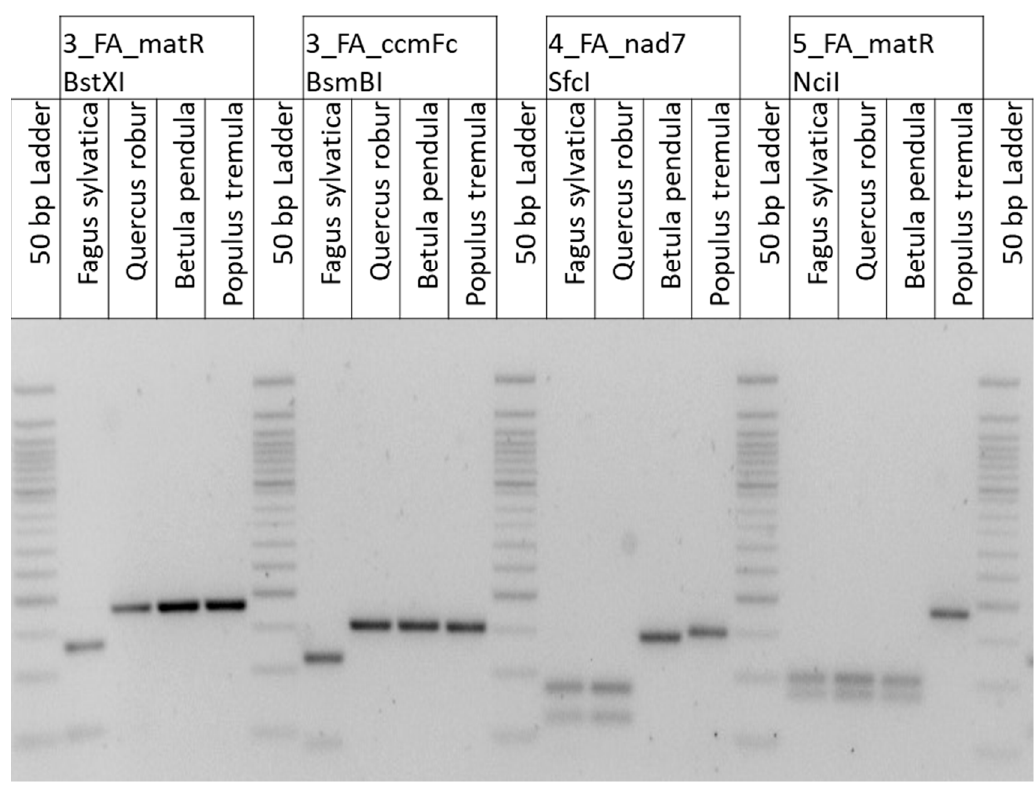
Figure 3. Representative restriction patterns of the CAPS markers (Table 1) analyzed in individuals of three Fagales and one non-Fagales species each. After digestion, PCR fragments were separated on a 1.5% agarose gel.